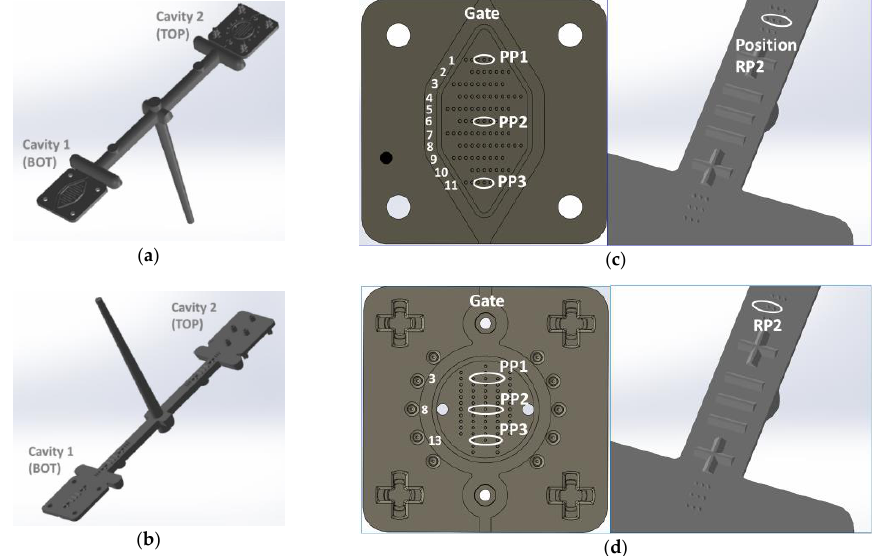
Figure 3. Molded geometry with fingerprint structures on the part and runners ( a , b ), and measurement positions on Cavity 1 ( c ) and Cavity 2 ( d ).